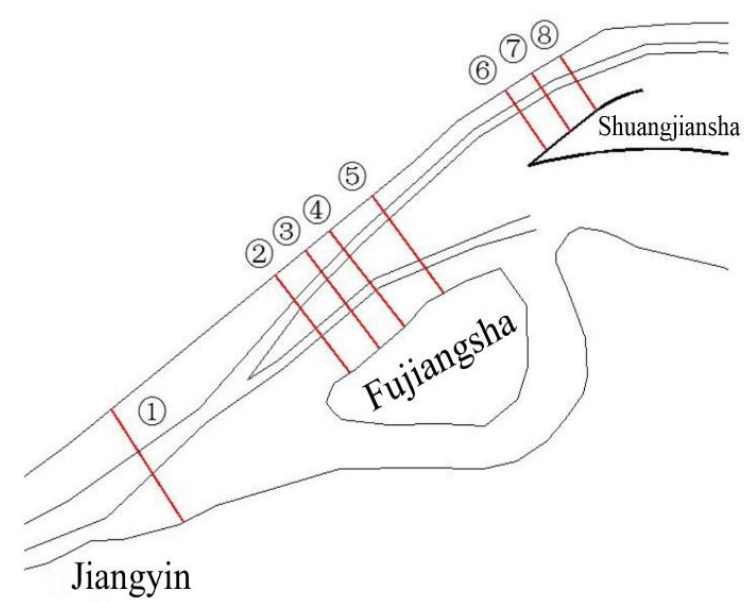
Figure 9. Positions of the sections in Fujiangsha Waterway before the project. from the numerical model. The results are shown in Table 3. Table 3. Equilibrium water depth of Fujiangsha Waterway.